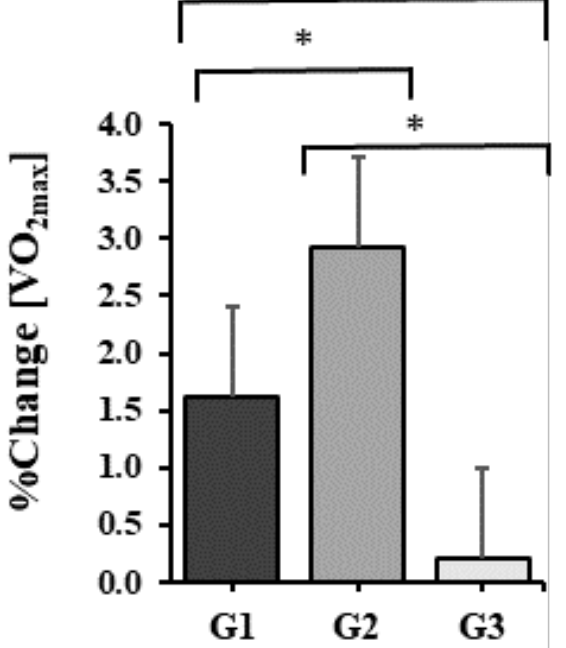
Figure 1. Relative before–after changes in VO2max concentration after 30 days of training at 2000 m altitude (G1), living at 1850 m and training at 2200 m (G2), namely 300 m (G3). Values displayed represent mean ± sd. Significant differences (p < 0.05) between training courses are marked with *.